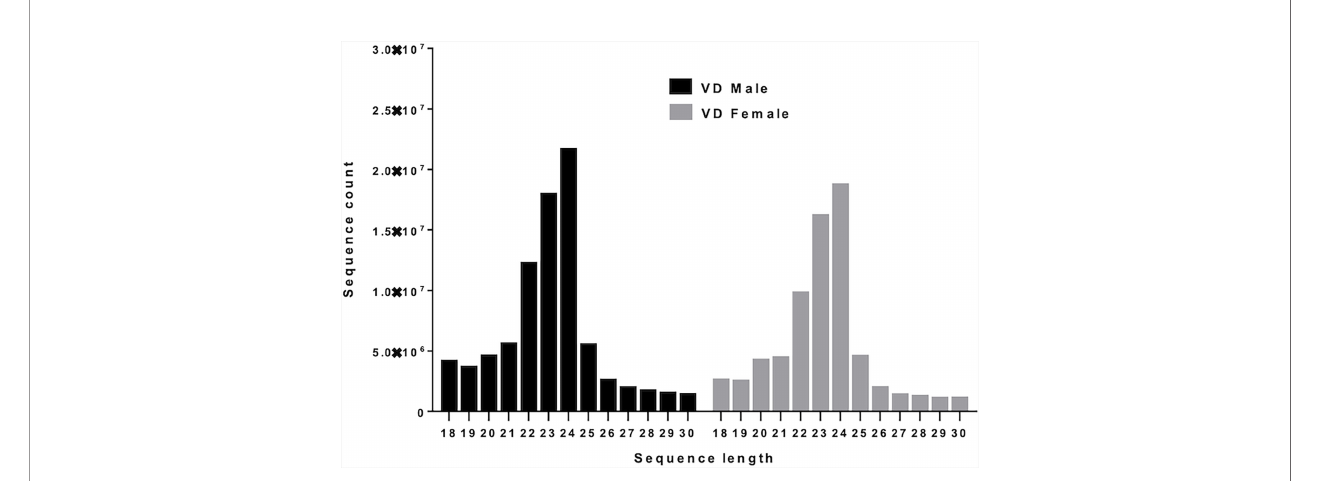
FIGURE 1 | Small RNA sequence length distribution of microRNAs in male and female Varroa destructor (VD) mites. MicroRNAs are twenty-four (24) nucleotides in